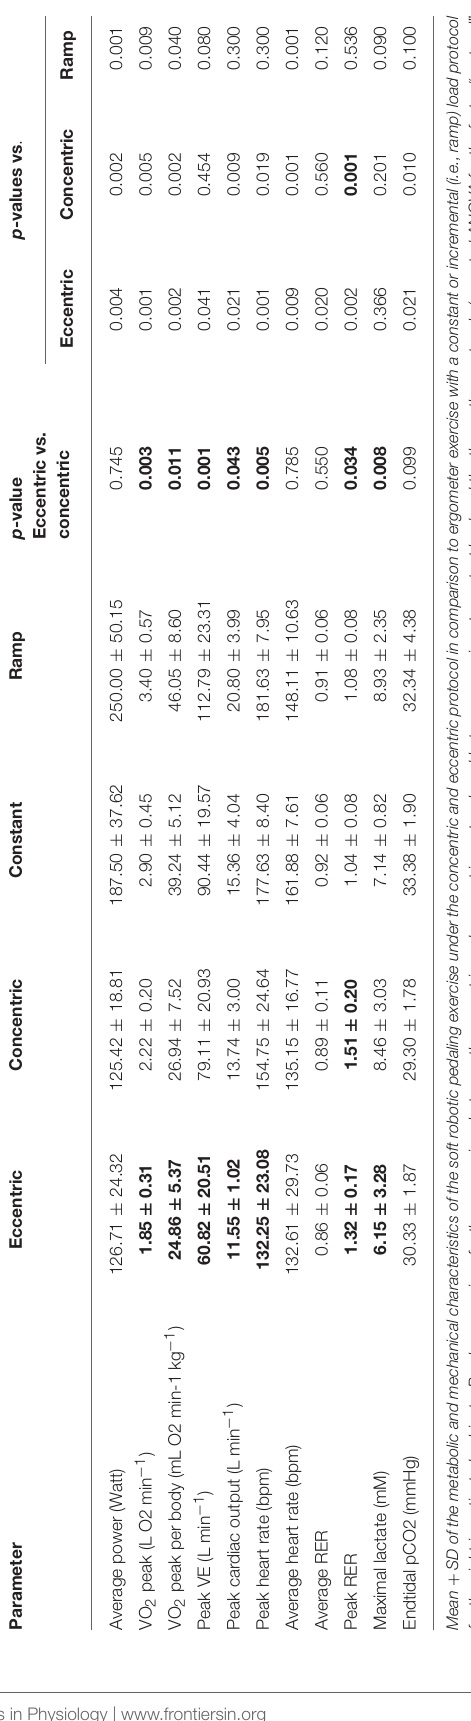
of power reduction post-exercise were also not correlated to the alterations in blood glucose. These observations in